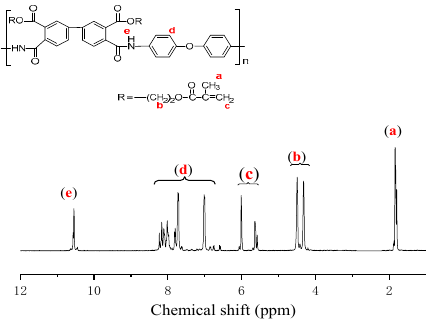
Figure 1. 1 H NMR spectrum of the pc-PAE resin.